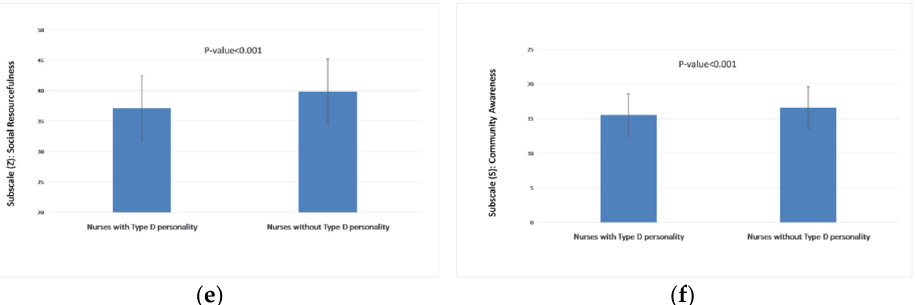
Figure 4. Relationships between Social Competences Profile and type D personality: ( a ) Social Competences Profile (PROKOS): Total score; ( b ) Subscale (A): Assertive competences; ( c ) Subscale (K): Cooperative competences; ( d ) Subscale (T): Social mindedness; ( e ) Subscale (Z): Social resourcefulness; ( f ) Subscale (S): Community awareness.